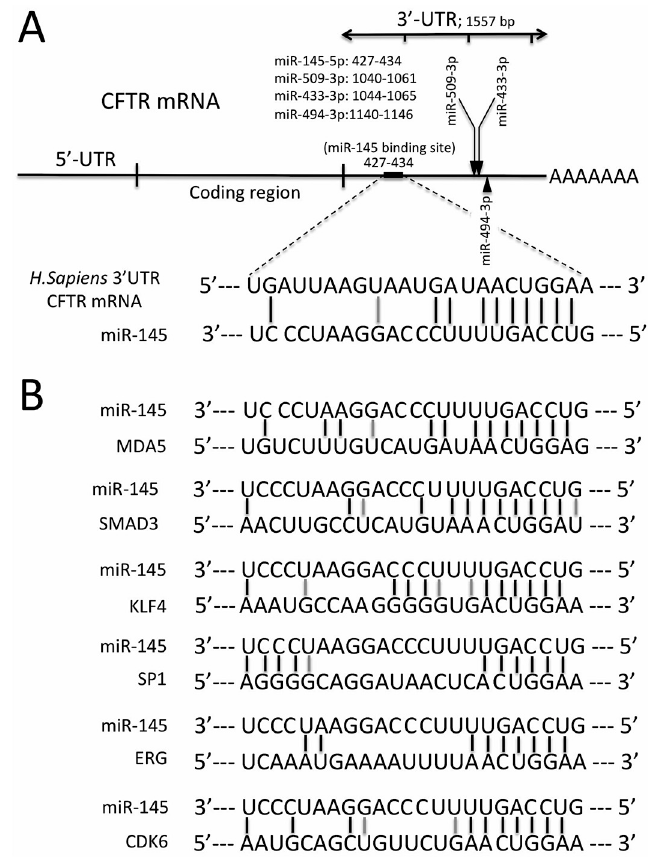
Figure 1. ( A ) Location of the miR-145-5p binding sites within the CFTR 3’-UTR region. ( B ) Interactions between miR-145 and validated mRNA targets: melanoma differentiation-associated protein 5 (MDA5) [33], SMAD family member 3 (SMAD3) [34], Kruppel-like factor 4 (KLF4) [35], specific protein Sp1 transcription factor (SP1) [36], ETS-related gene (ERG) [37] and cyclin dependent kinase 6 (CDK6) [36]. GC/CG and AT/TA: black lines; GU/UG: gray lines.